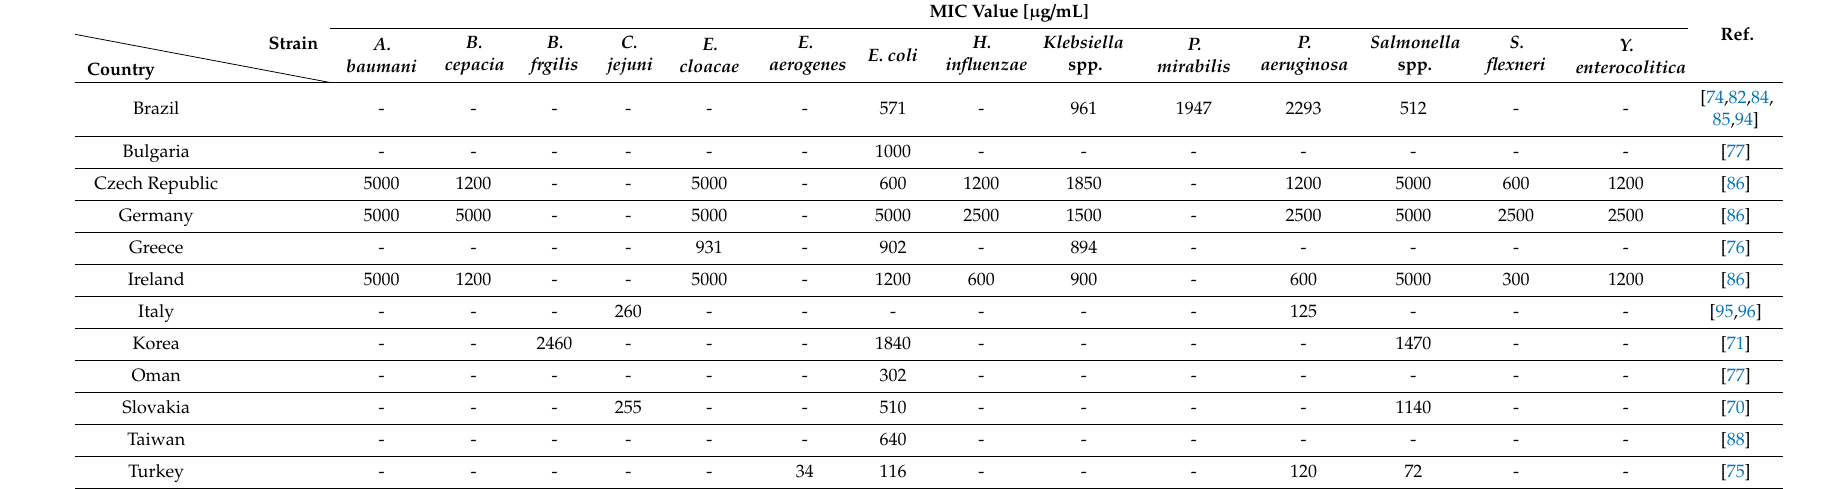
Table 4. The MIC values for EEP from di ff erent geographical origin against Gram-negative bacteria (“-”—no data). MIC Value [ µ g / mL]